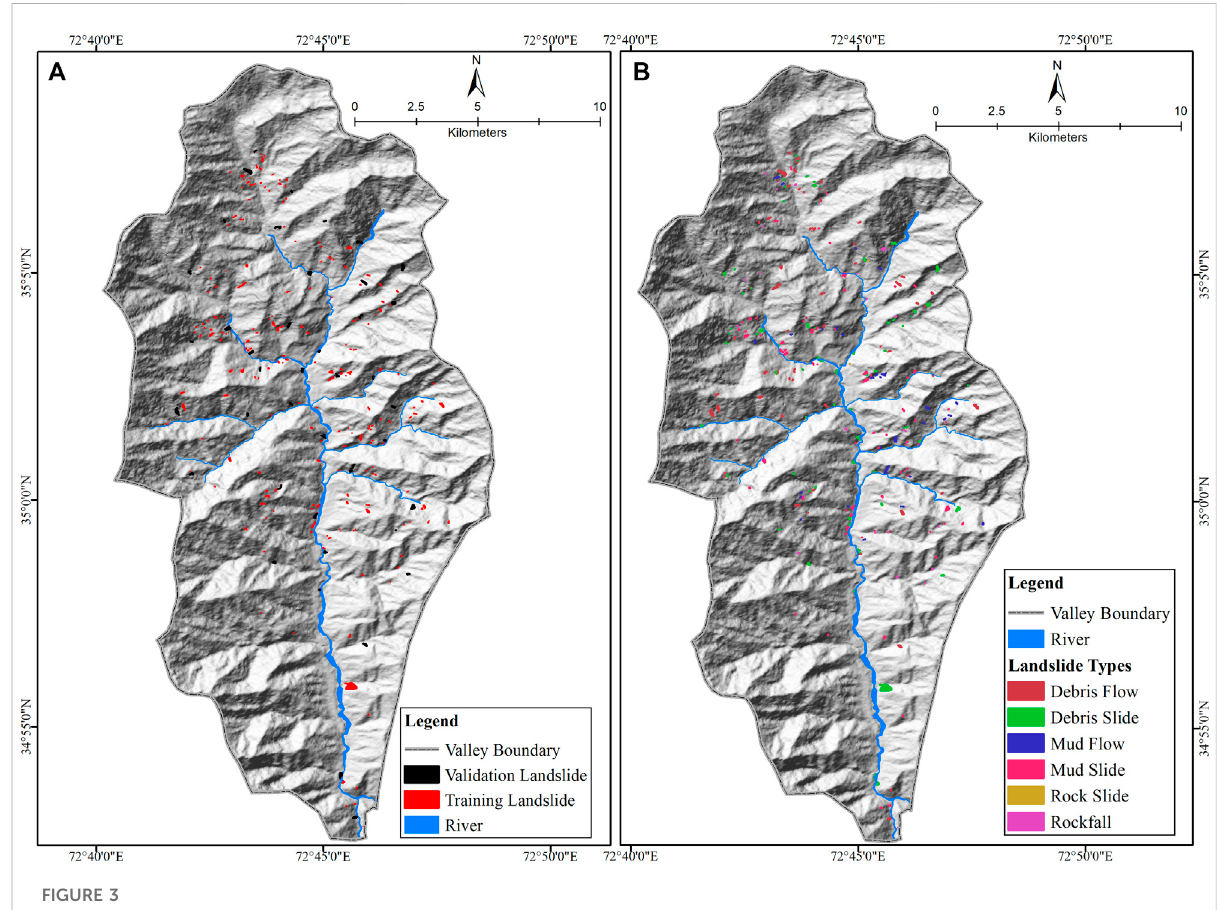
FIGURE 3 Shahpur valley: (A) distribution of past landslides and (B) types of